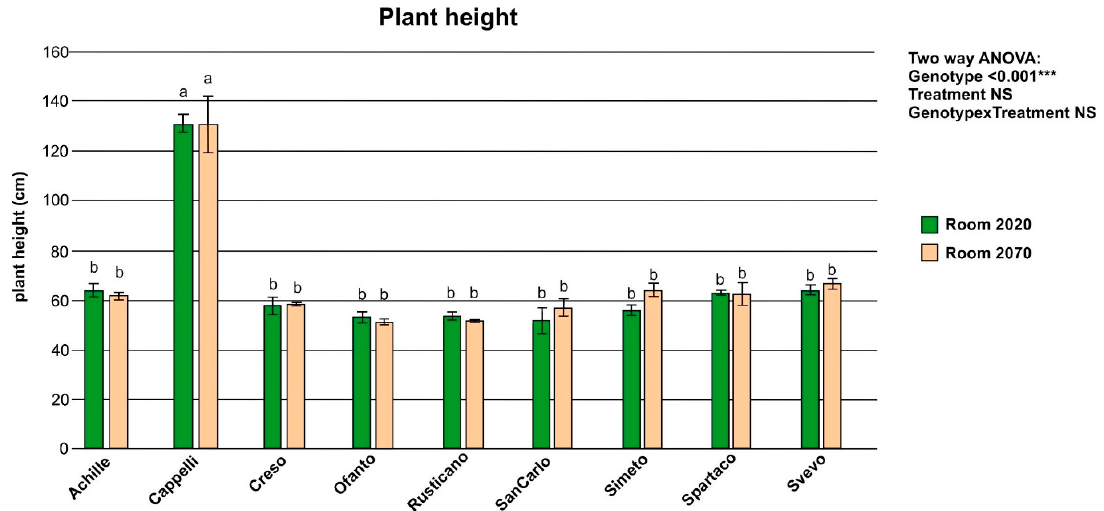
Figure 2. Plant height per pot of the individual varieties grown in “room 2020” and in “room 2070”. Each biological replicate had three seedlings per pot. Top right: Two-way ANOVA results. Letters a and b refer to significantly different means across the genotypes and the treatment (Tukey-HSD, “honestly signi fi cant di ff erence” post hoc test, p < 0.05).